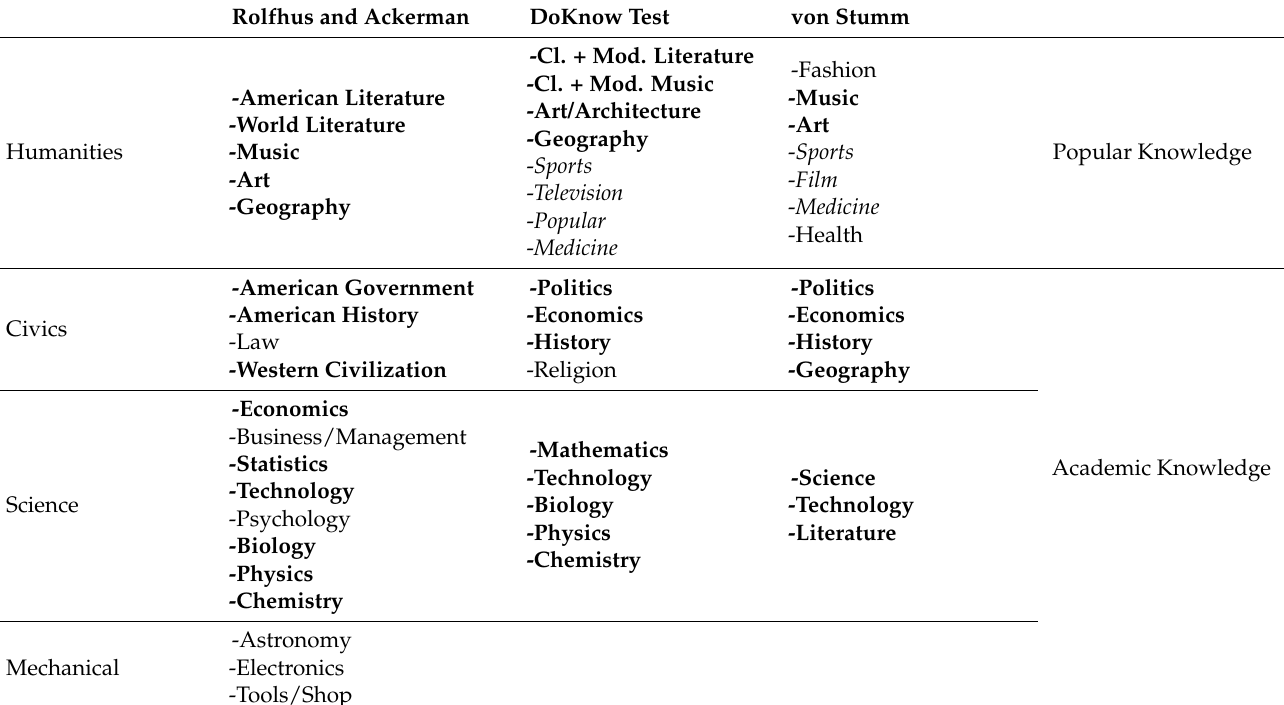
Table 1. Structural Comparison of the 3 Gkn